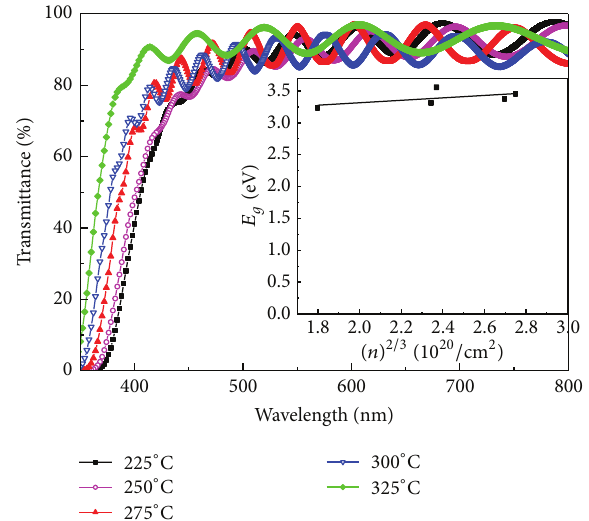
Figure 6: The transmittance of the as-deposited films for different substrate